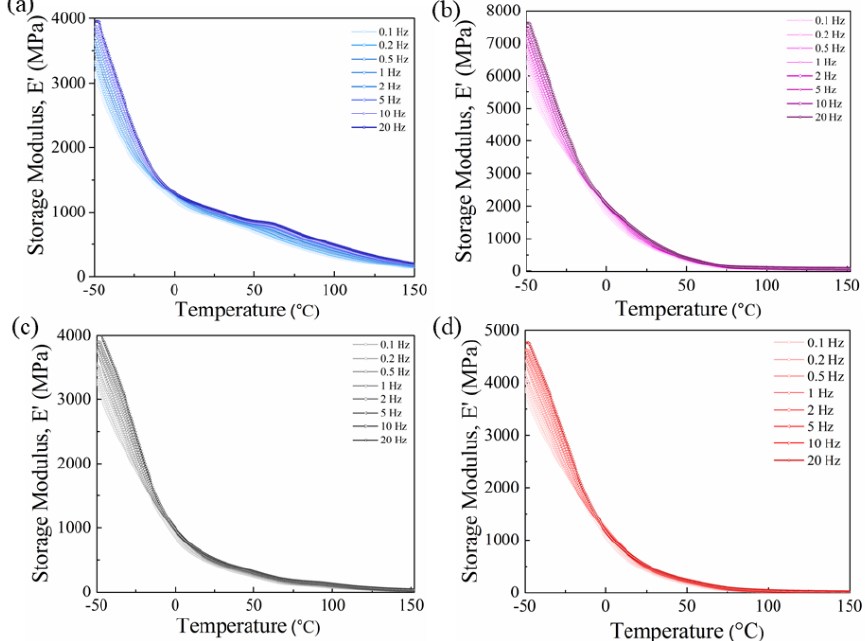
Figure 4. Storage modulus vs. temperature for ( a ) PVDF, ( b ) PVDF/BT, ( c ) PVDF/rGO, and ( d ) PVDF/rGO/BT fibers obtained from DMA measurement. In all cases, the storage modulus was determined at a range of oscillation frequencies, as indicated.